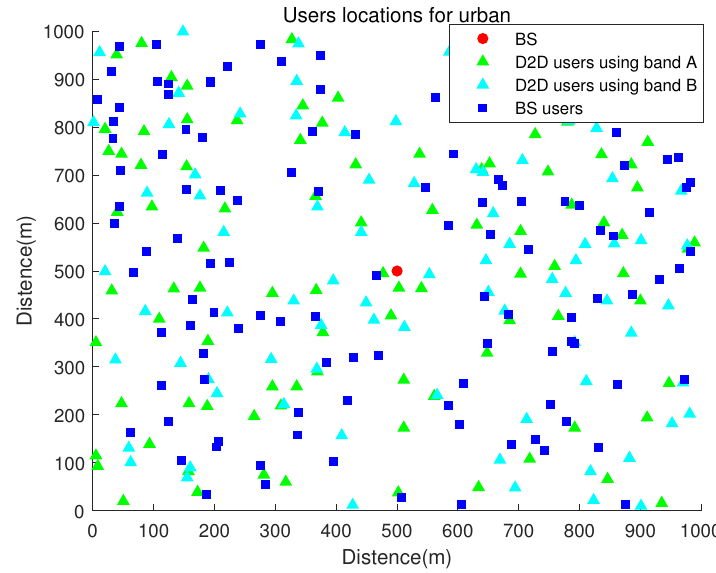
Figure 14. Location map after GADIA for urban